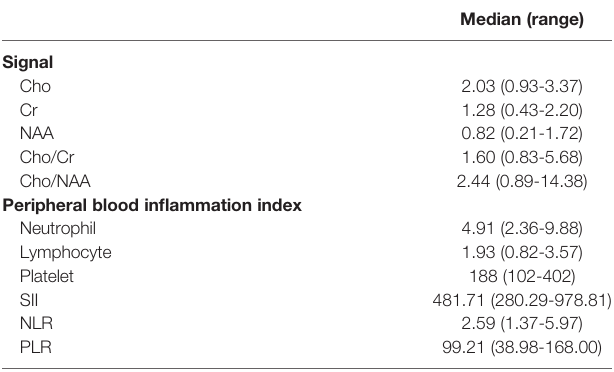
TABLE 2 | A summary of MRS metabolic characteristics and in fl ammation index.